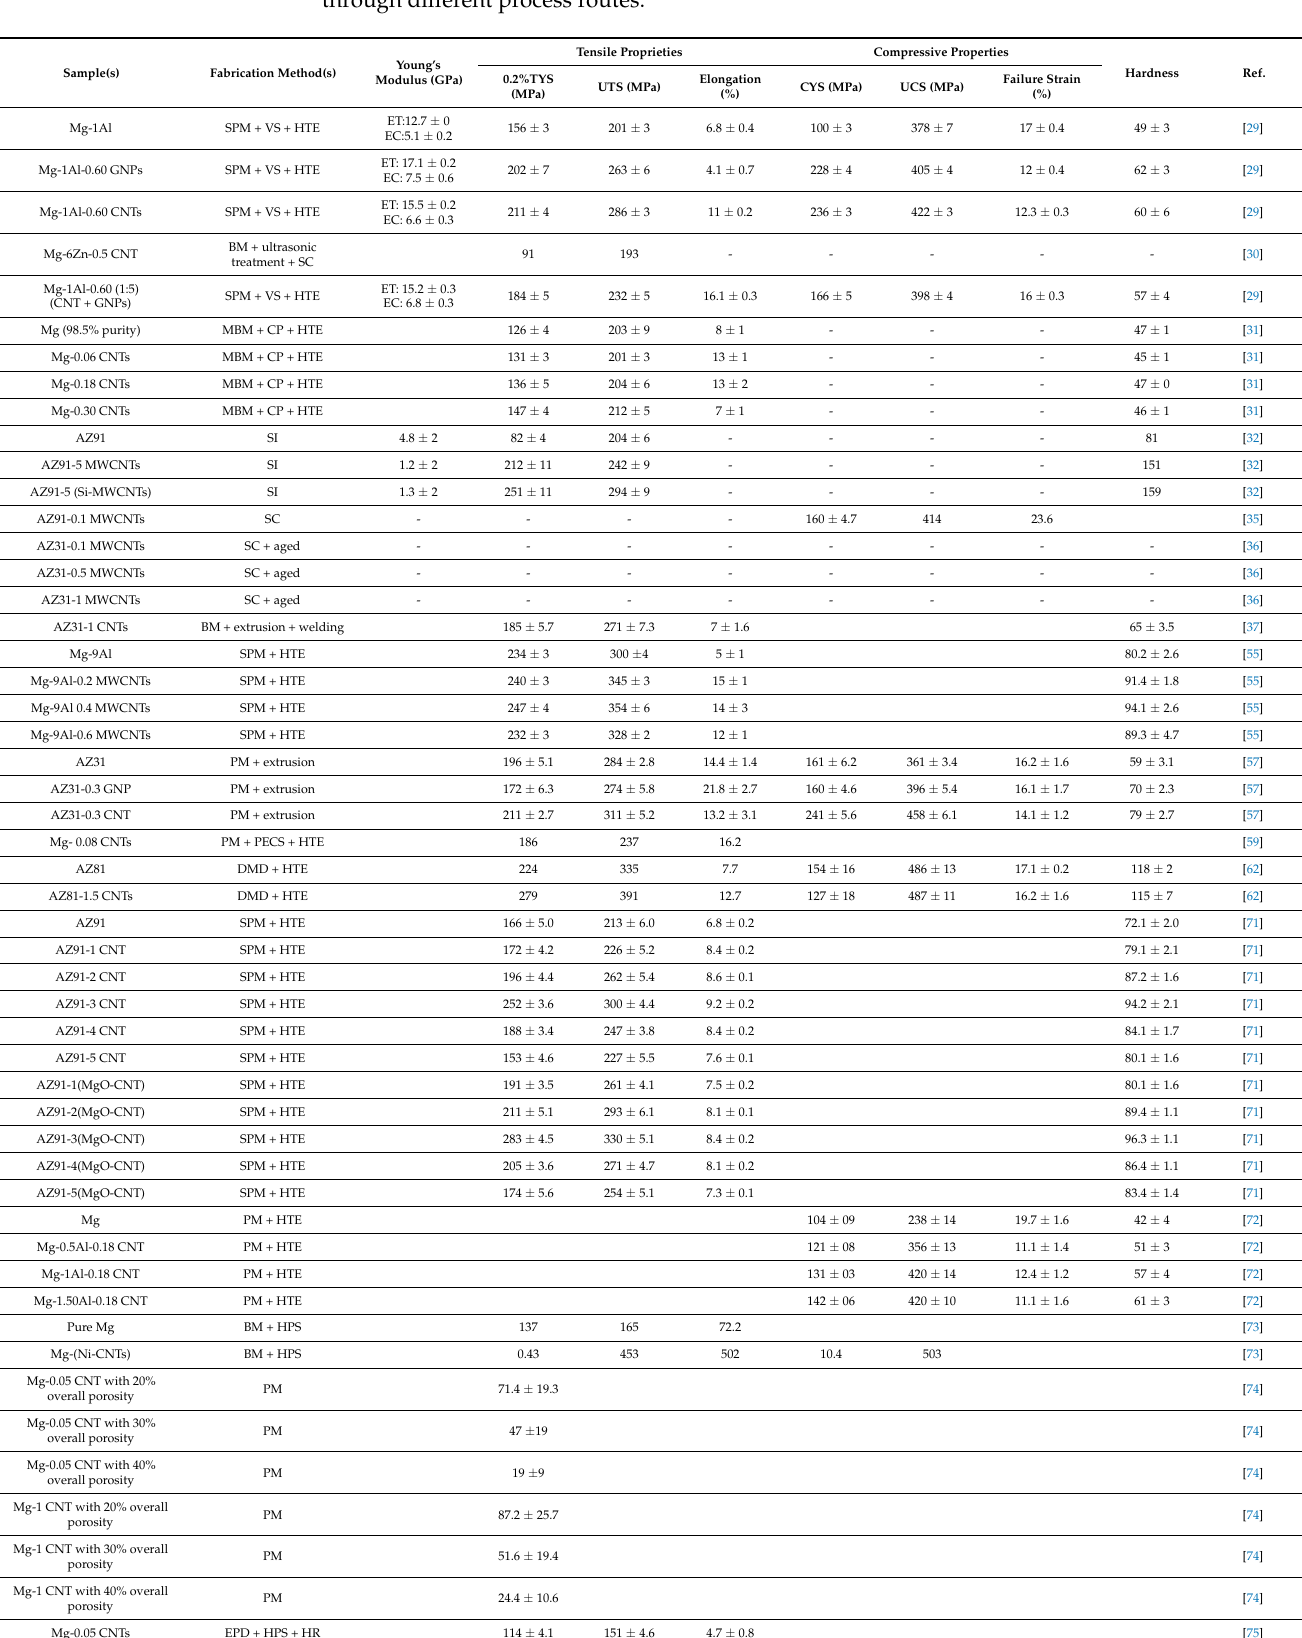
Table 1. Summarized investigated mechanical properties obtained in Mg/CNT composites fabricated through different process